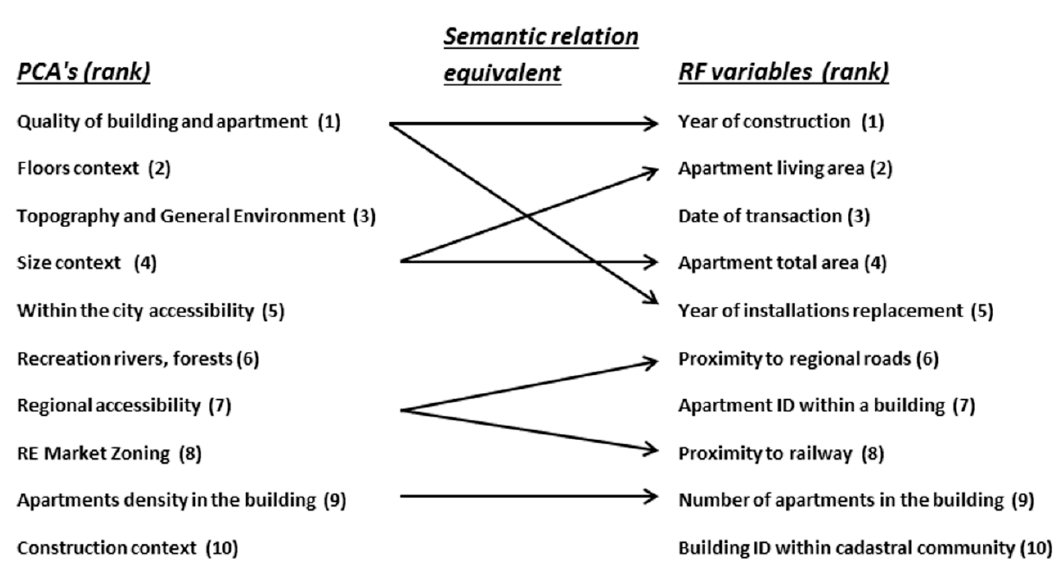
Figure 4. Semantic comparison of the top ten Principal Components (PCs) with the set of top ten ranked predictors selected by random forest (RF).